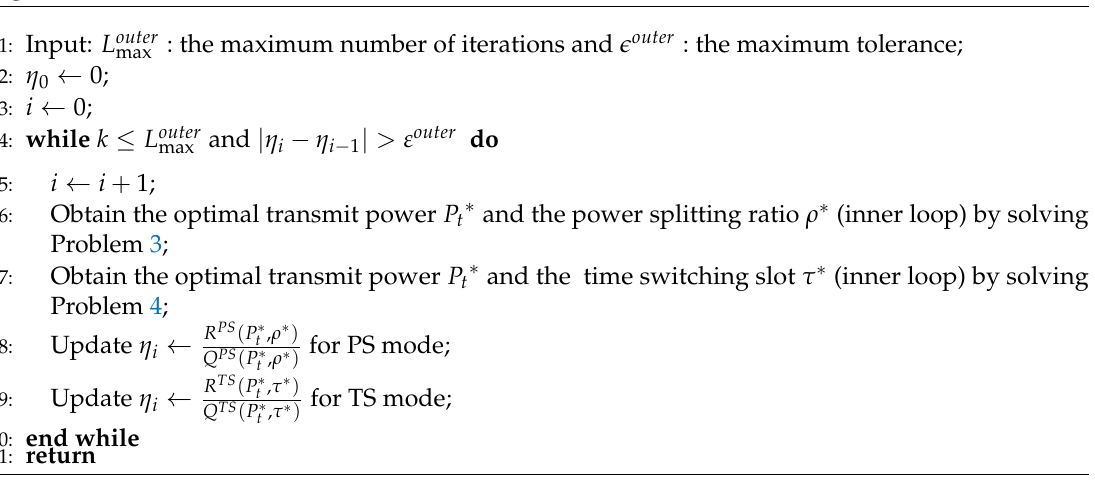
Algorithm 2 Dinkelbach’s method for EE